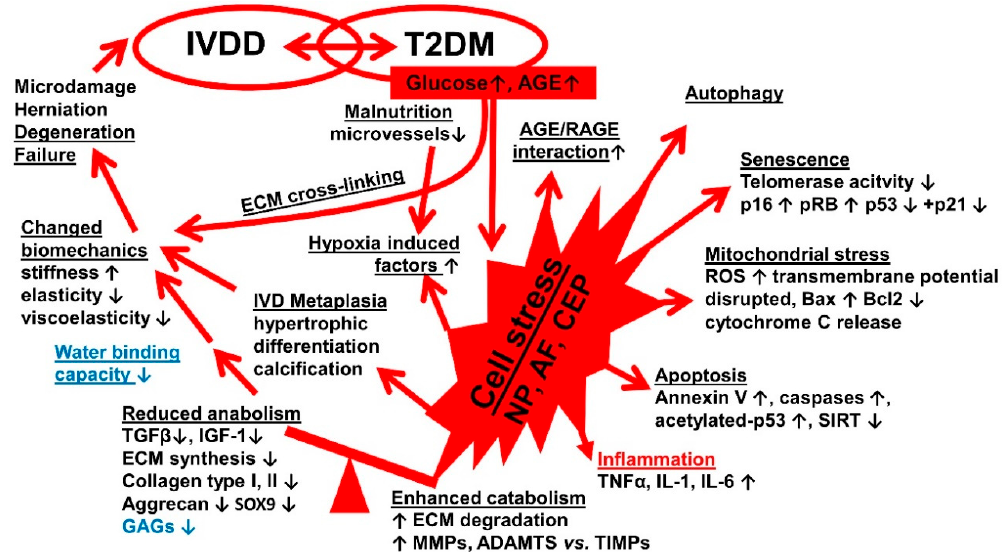
Figure 4. Crucial aspects of the linked pathogenesis of IVDD in T2DM are identified using rodent models. Data depicted here was extracted from studies summarized in Table 4. ADAMTS: a disintegrin and metalloproteinase with thrombospondin motifs, AGE: advanced glycosylation end-products, Bax: Bcl-2 associated protein X, Bcl-2: B-cell lymphoma 2, ECM: extracellular matrix, GAG: glycosaminoglycans, IGF-1: insulin growth factor-1, IL: interleukin, IVDD: intervertebral disc degeneration, MMP: matrix metalloproteinase, RAGE: a receptor for advanced glycation end-products, ROS: reactive oxygen species, SIRT: sirtuin, pRB: retinoblastoma protein, SOX9: sex-determining region SRY of the Y chromosome, TIMPs: tissue-specific inhibitor of matrix metalloproteinases, TNF α : tumor necrosis factor α , T2DM: diabetes mellitus type II, TGF β : transforming growth factor β .